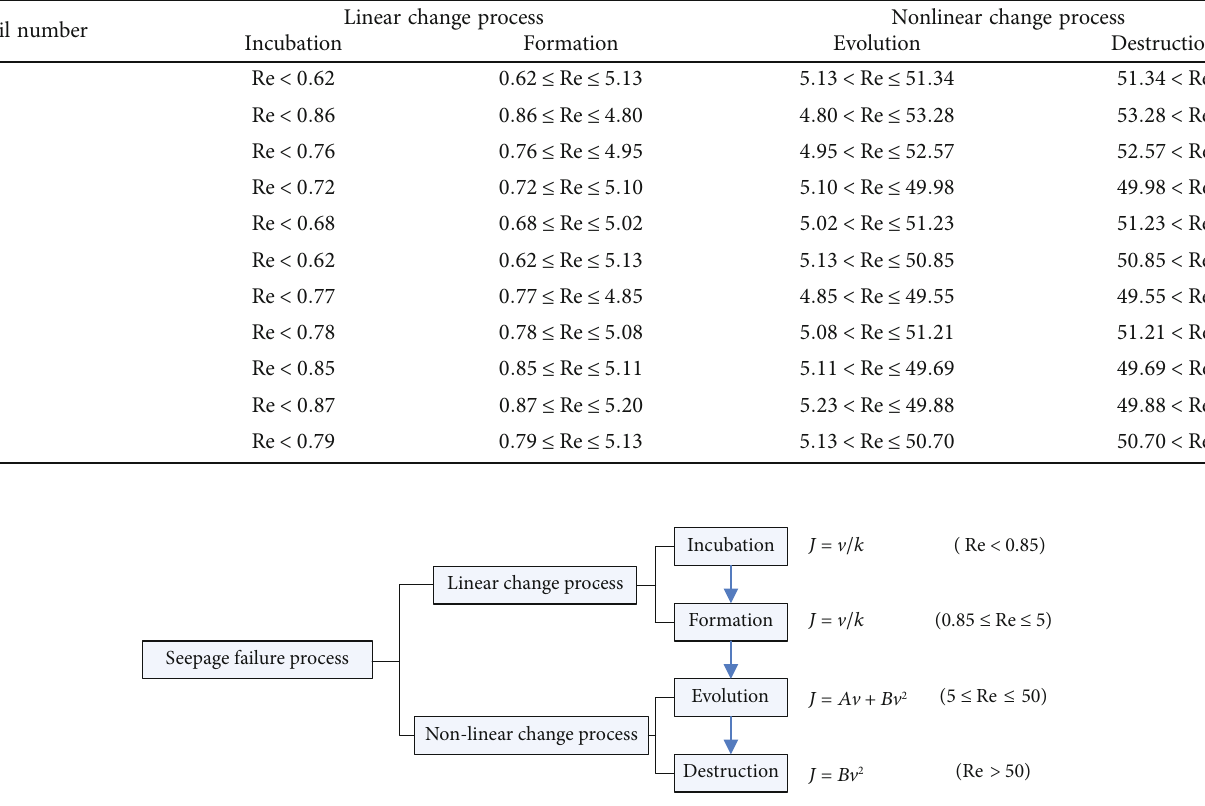
Figure 20: Piecewise function of seepage failure process division with the Reynolds